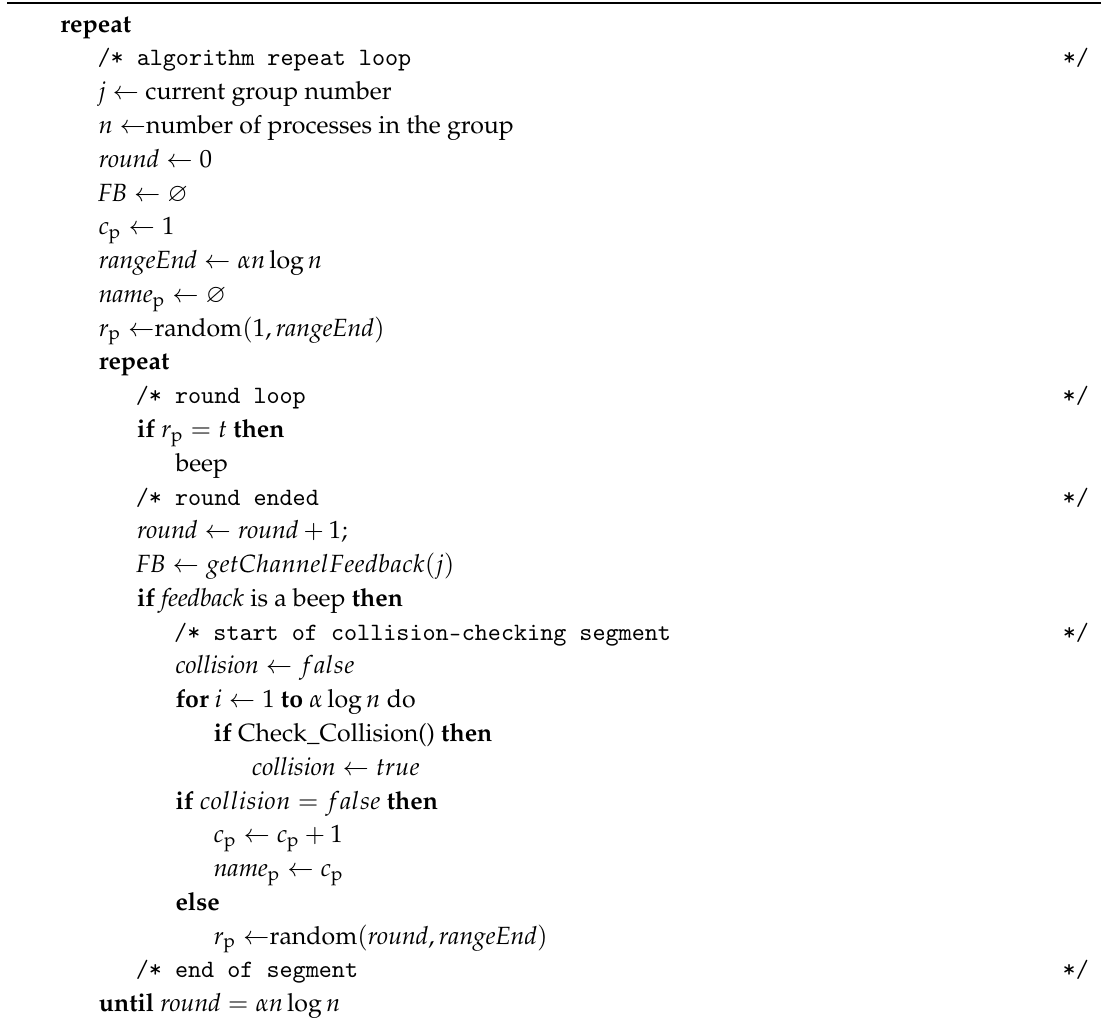
Algorithm 1: S INGLE G ROUP B EEP N